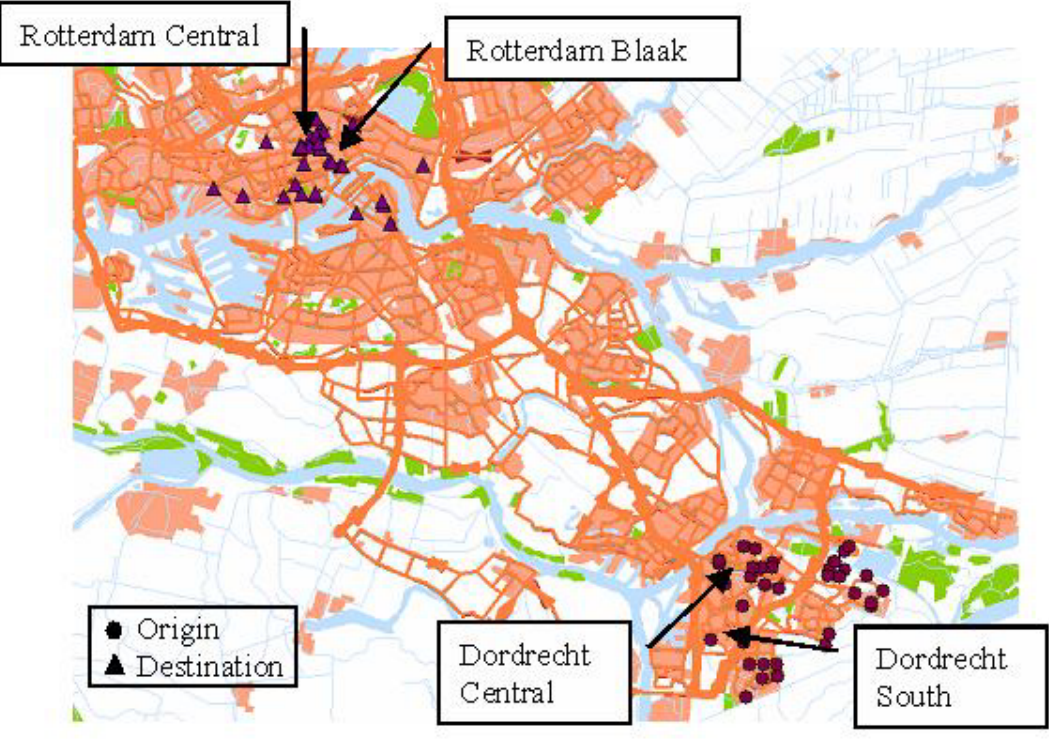
Figure 1. Overview of the corridor Dordrecht-Rotterdam and the selected trip origins and